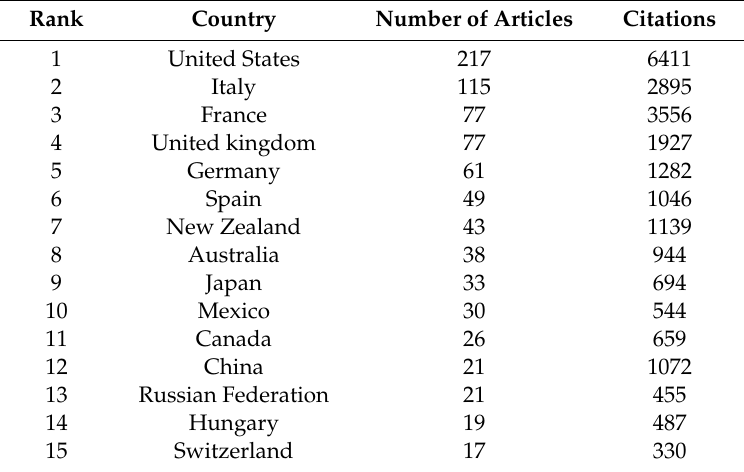
Table 3. Main documents with the most citations.